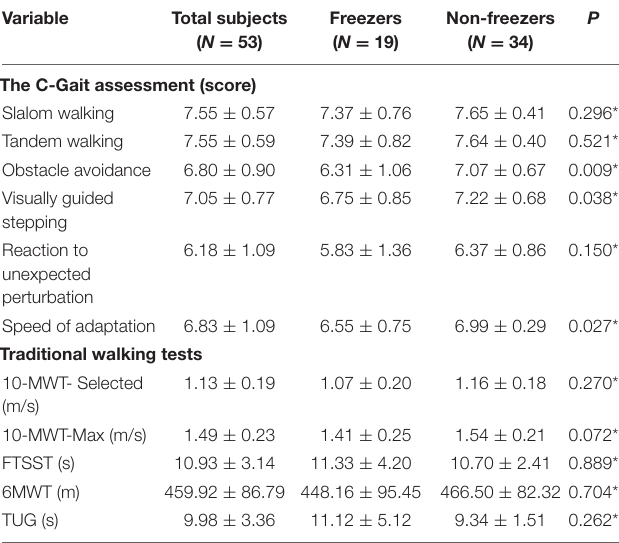
TABLE 2 | Differences between freezers and non-freezers in C-Gait assessment scores and clinical tests